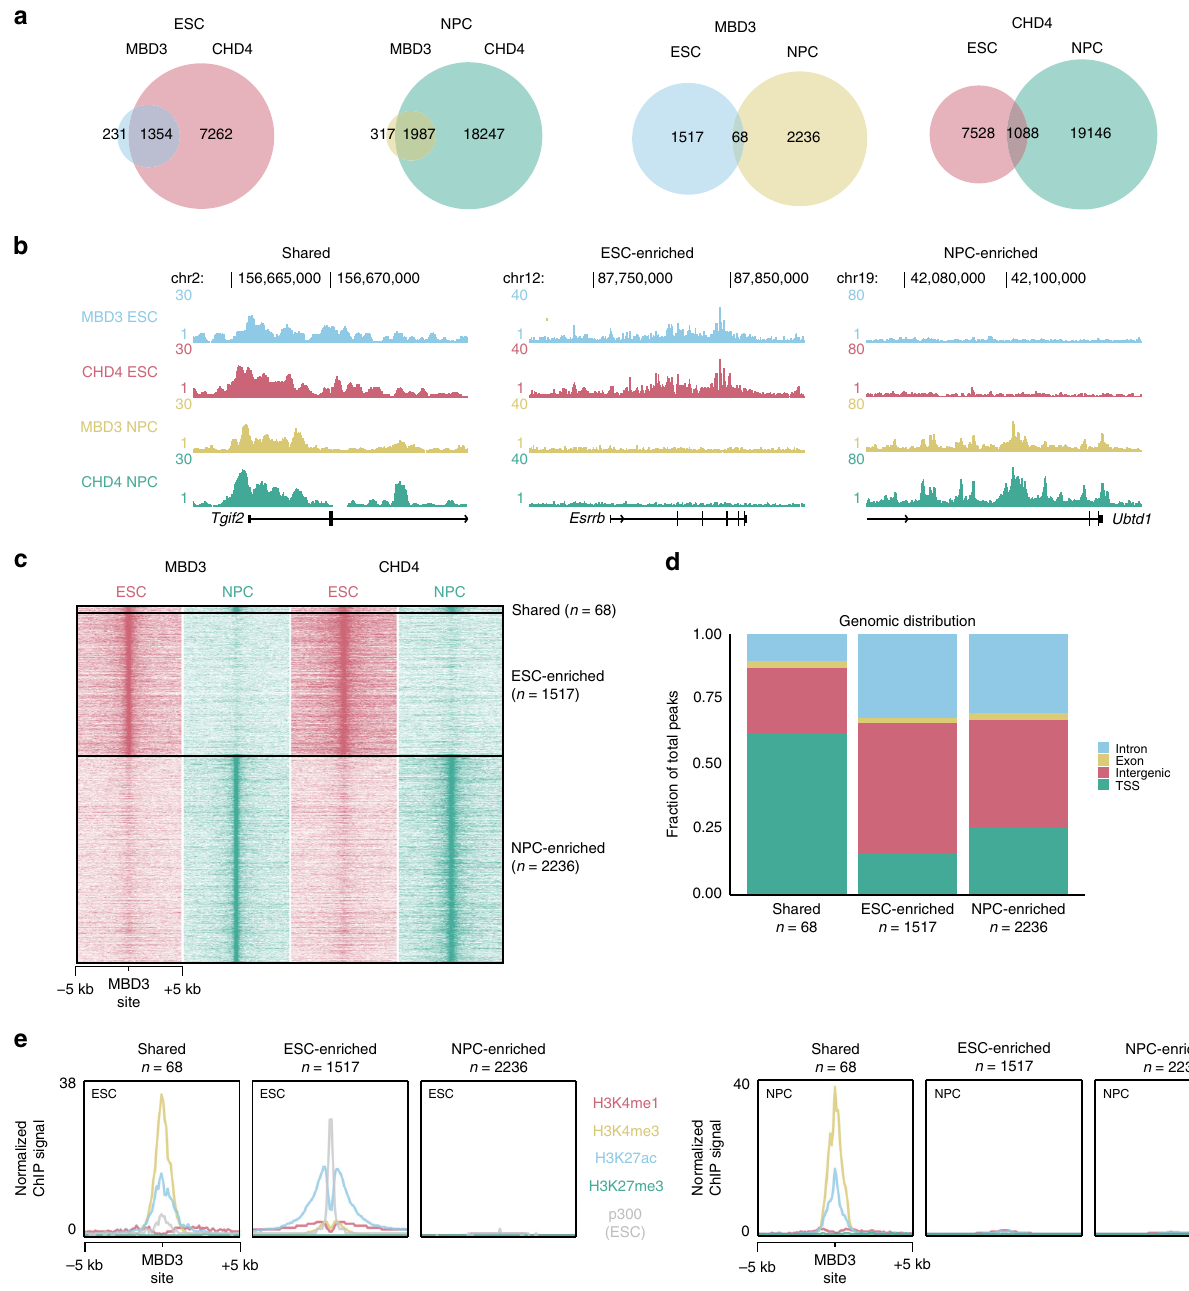
Fig. 1 Dynamic NuRD binding sites map to active promoters and enhancers in ESCs. a Venn diagrams summarizing NuRD ChIP-seq results in embryonic stem cells (ESC) and neural progenitor cells (NPC). b UCSC genome browser screenshots of example loci where NuRD binding is shared between ESC and NPC (left), enriched in ESC (middle), or enriched in NPC (right). c Heat map showing the ChIP-seq read density for MBD3 and CHD4 in ESC and NPC, centred on the union of MBD3 peaks from ESC and NPC. d Genomic distribution of NuRD ChIP-seq peaks from each class as shown in b and c . TSS peaks were + 5 kb/ − 1 kb from a transcription start site. e Band plots of four different histone marks and p300 (in ESCs, publicly available data 19 ) ChIP-seq at MBD3 binding sites for each class of NuRD binding. See also Supplementary Fig.